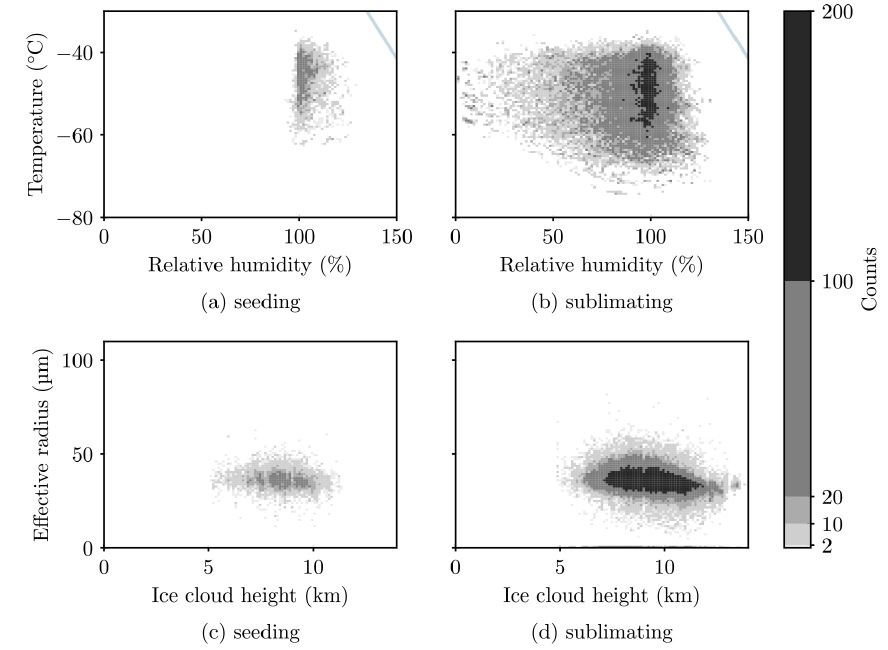
Figure B3. Same as Fig. 5 but assuming bullet rosettes as seeding ice